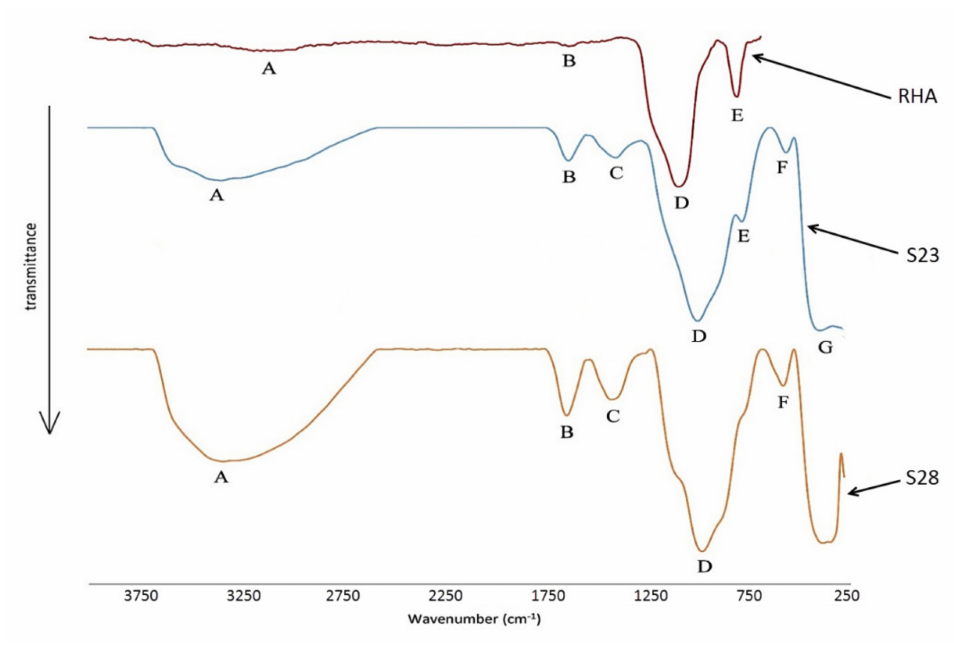
Figure 15. FTIR spectra of RHA, sample S23, and S28. Table 10. Characteristic bands of each spectrum in RHA and sample S23, and